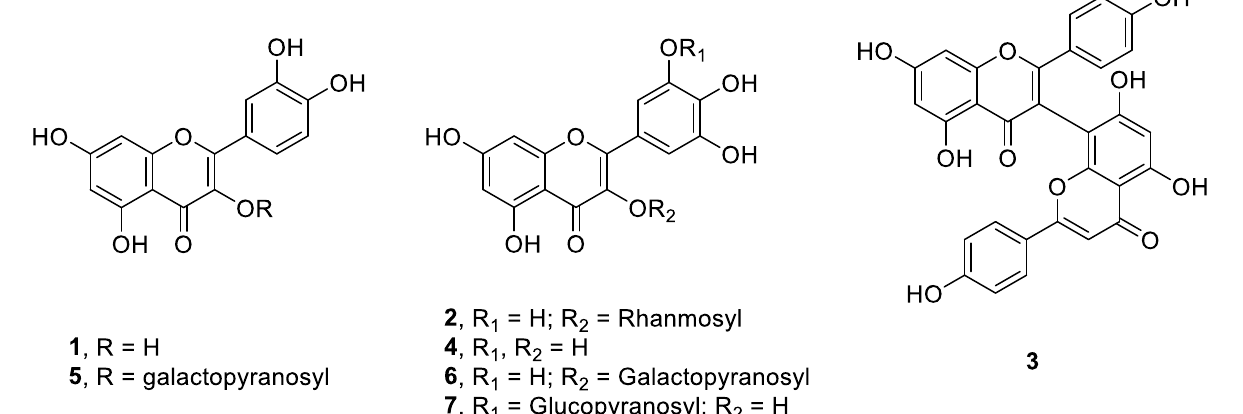
Figure 1. Structure of isolated compounds ( 1 – 7 ). None of the fractions or pure compounds showed in vitro antileishmanial activities (Tables 1 and 2). Regarding the antitrypanosomal activity, the chloroform, ethyl acetate and n-butanol fractions of H. afrum showed significant inhibitory activity against T. brucei culture, with IC 50 values of 12.35, 13.53 and 12.93 and with IC 90 values of 14.94, 19.31 and 18.67 µg/mL, respectively. Only compounds 1 and 4 from the ethyl acetate fraction were found to have antitrypanozomal activity. All the samples were simultaneously tested against THP1 cell for the determination of general cytotoxicity. Compounds 1 and 4 showed potent activity against T. brucei at IC 50 values of 7.52 and